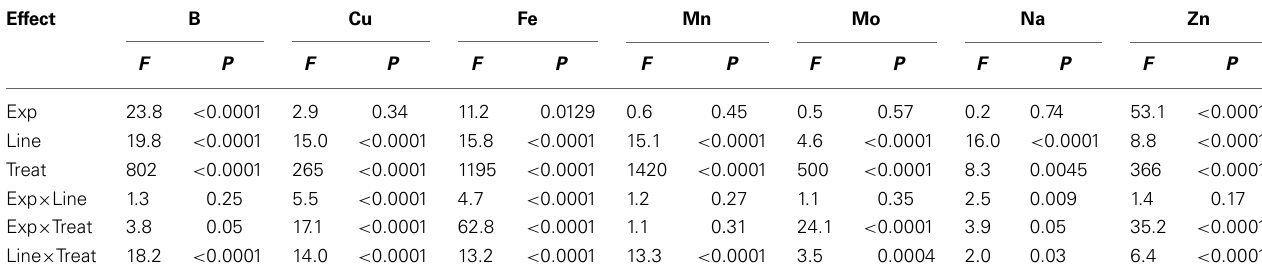
Table 4 | Analysis of variance ( F and P values) of the effects of water treatment (Treat) on micronutrients in the fully expanded leaves at boll stage development in fuzzless and fuzzy seed cotton isogenic mutant lines (Line) in greenhouse experiments